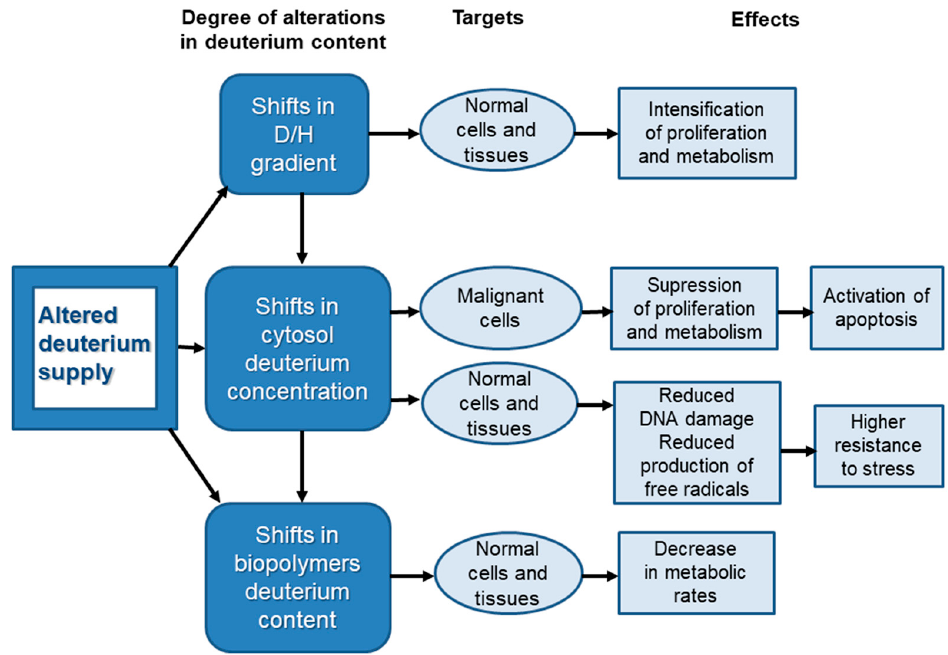
Figure 2. Probable mechanisms of changes in cytophysiology by shifts in deuterium content.